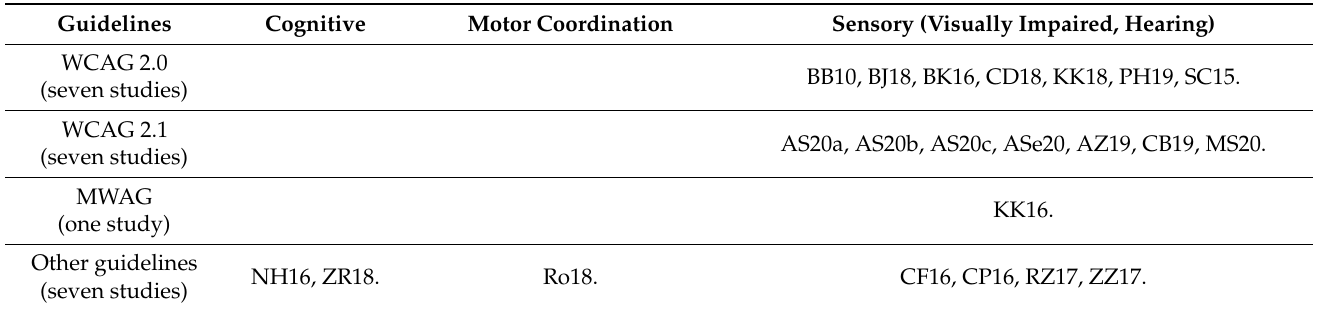
Table 7. Guidelines and disability.